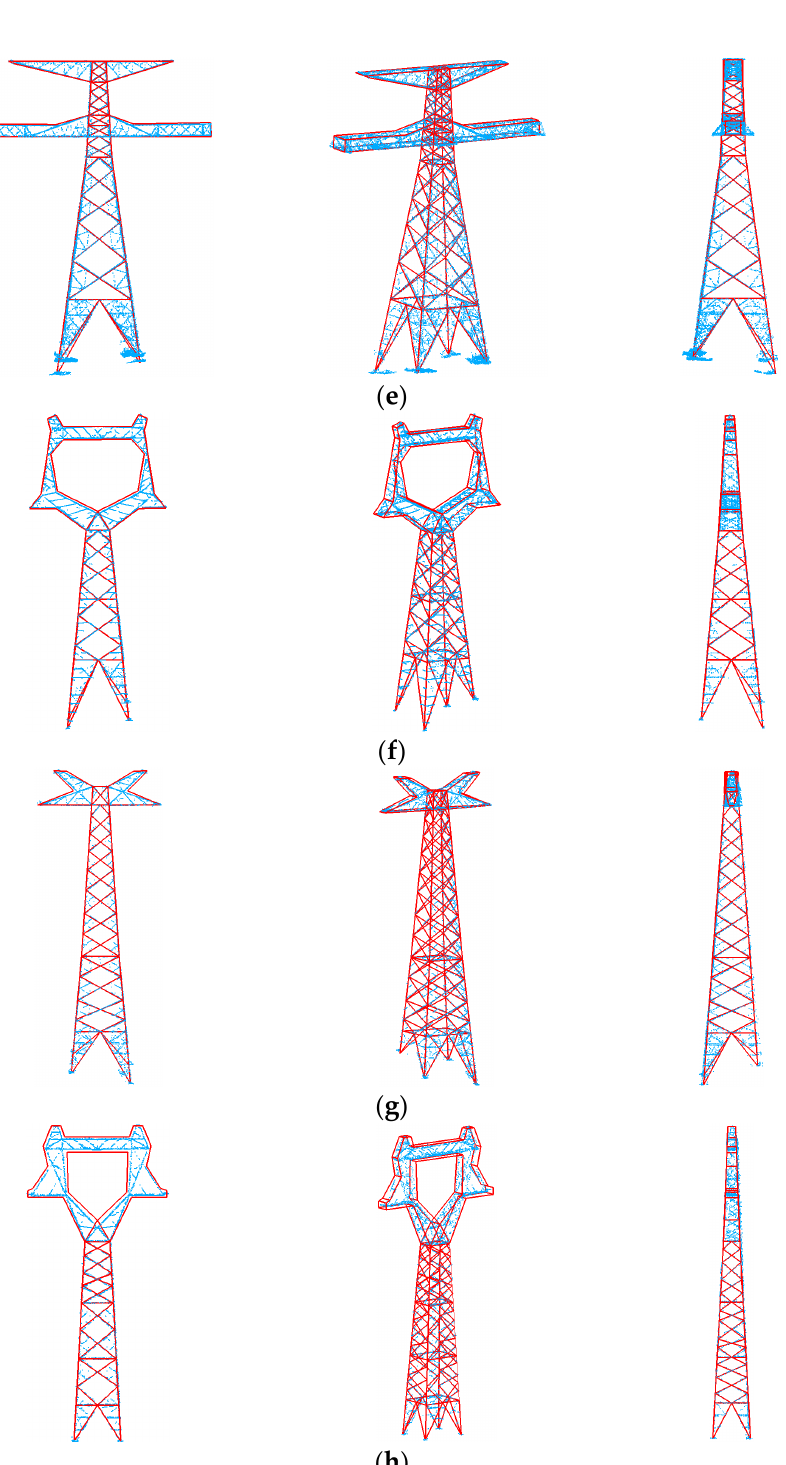
Figure 24. The 3D result of multi-type pylons reconstruction. ( a ) the three views of pylon model of type-a; ( b ) the three views of pylon model of type-b; ( c ) the three views of pylon model of type-c; ( d ) the three views of pylon model of type-d; ( e ) the three views of pylon model of type-e; ( f ) the three views of pylon model of type-f; ( g ) the three views of pylon model of type-g; ( h ) the three views of pylon model of